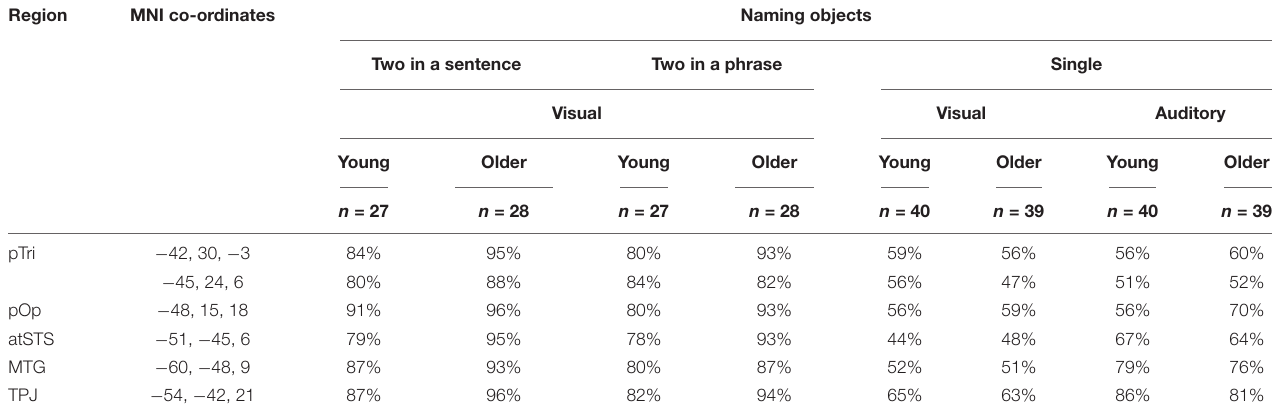
TABLE 4 | Consistency of activation for younger versus older participants. Region MNI co-ordinates Naming objects Two in a sentence Two in a phrase Single Visual Visual